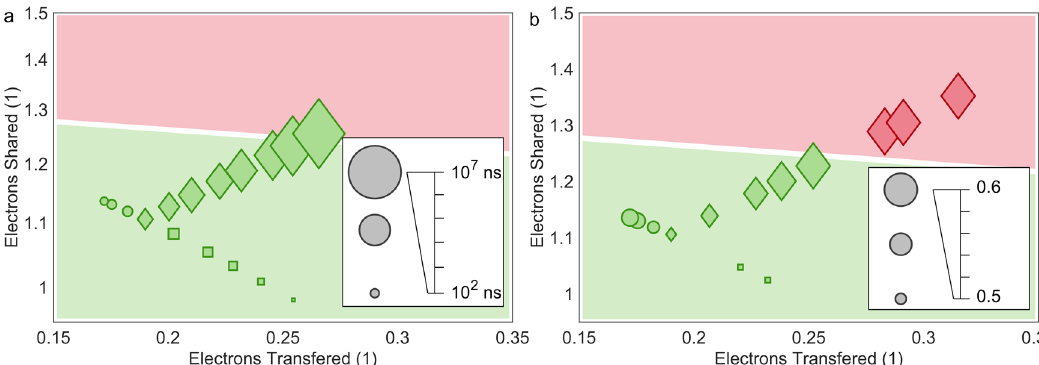
Fig. 4 Change of kinetics with bond indicators. Dependence of the minimum crystallization time τ ( a ) and the reduced onset temperature T ro for glass formation ( b ) upon two chemical bond quanti fi ers, the number of electrons transferred and shared between adjacent atoms. A pronounced decrease of the minimum time to crystallize and the glass-forming ability is observed in the metavalent bonding region (green background) between covalent (red) and metallic bonding. Figure 4a, in conjunction with Fig. 2a, shows that the crystallization time τ is clearly correlated with the number of electrons shared. For the Se-rich compounds, which are covalently bonded such as GeSe, crystallization is not even discernible in the optical